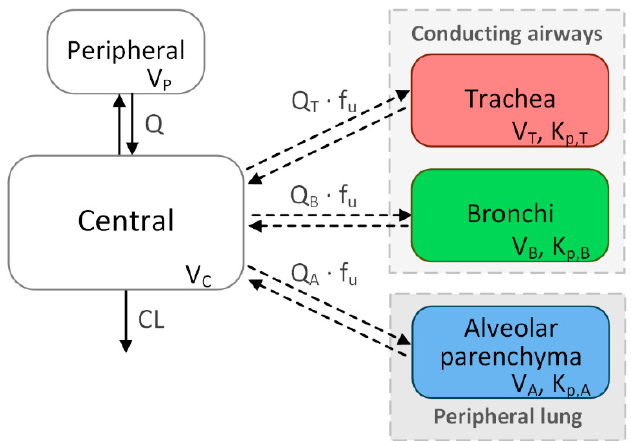
Figure 2. Structure of the pharmacokinetic (PK) model. CL: systemic clearance, V C : central volume of distribution (Vd), Q: intercompartmental clearance, V P : peripheral Vd; Q T , Q B , and Q A represent the blood flow to the trachea, bronchi and alveolar parenchyma, respectively. f u : fraction unbound in the plasma, V T : weight of the trachea, V B : weight of the bronchi, V A : weight of the alveolar parenchyma.